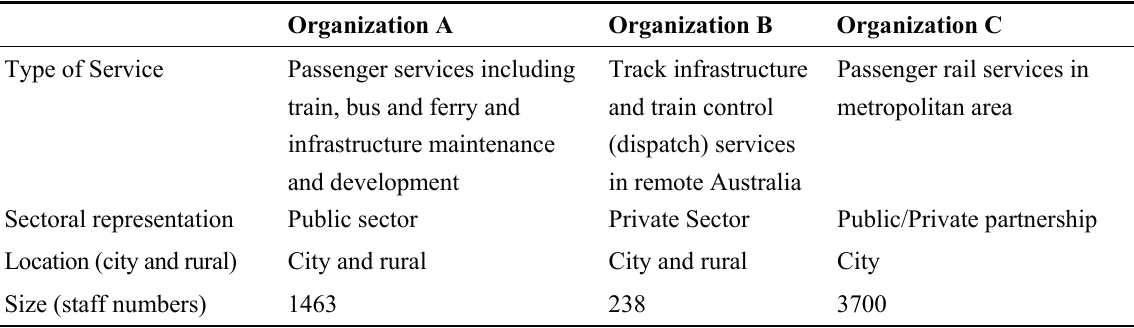
Table 1. Characteristics of organizational